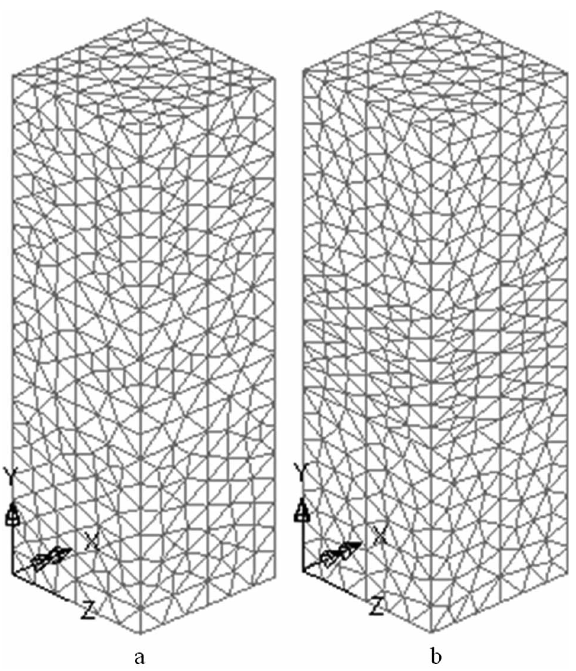
Fig. 8. Typical finite element meshes of the stiffened CFSC stub columns: (a) column with 2 bar stiffeners and spacing of 150 mm; (b) column with 3 bar stiffeners and spacing of 100